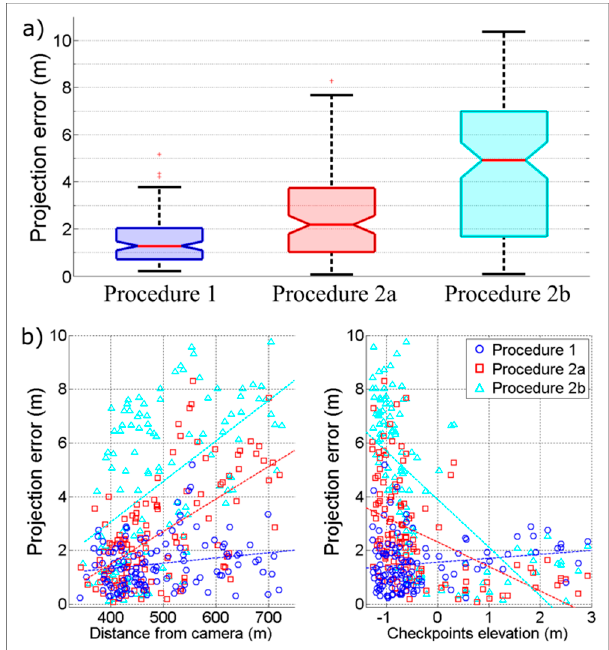
Figure 10. Projection error obtained for the 119 checkpoints on the intertidal area. ( a ) boxplot of projection errors; ( b ) error dependence on distance from the camera ( left ) and on checkpoints elevation ( right ). Table 3. Camera parameters results. Parameters set fixed during the iterative process are written in bold. Displacement to the remotely-derived camera location are is shown along the three relative dimensions ( d x , d y , d z ) and in term of Euclidean distance (dist).